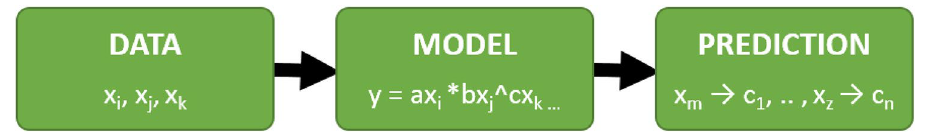
Figure 2. Illustrative box diagram of a general machine learning classification